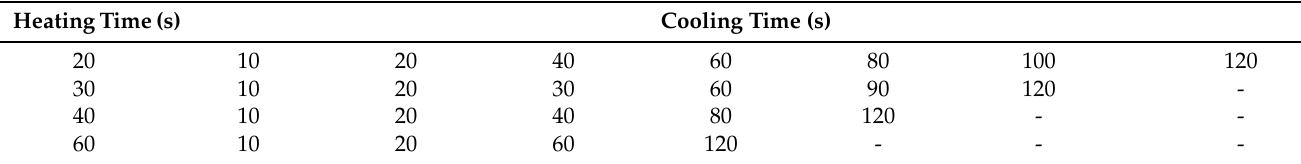
Table 1. Heating and cooling duration combinations considered for each cycle during IRT